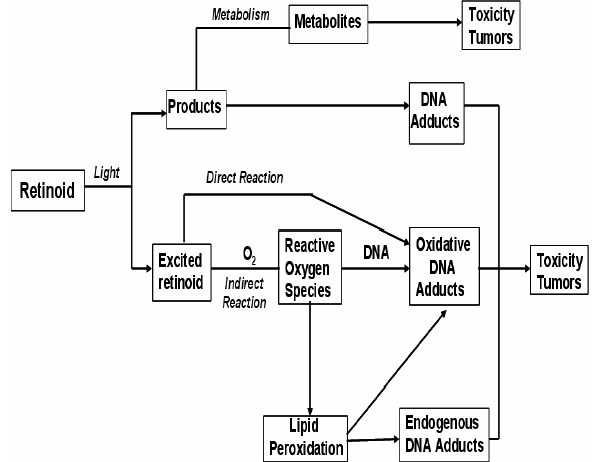
Figure 8: Potential photoreaction pathways of retinoids leading to phototoxicity and tumor